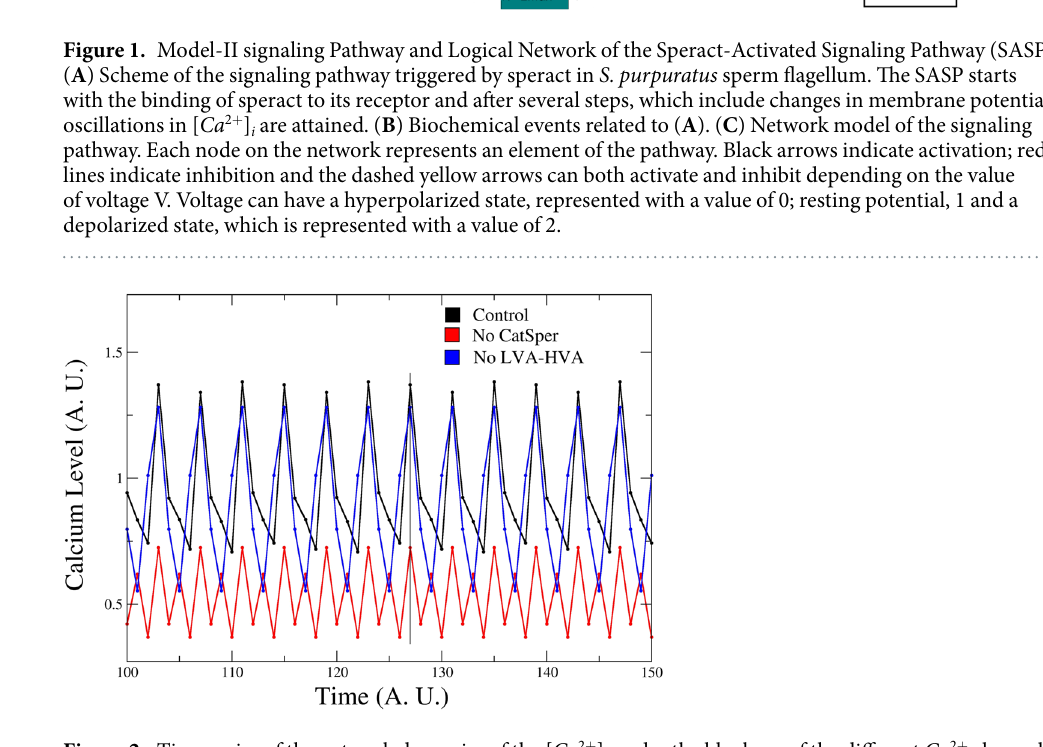
Figure 2. Time series of the network dynamics of the [ Ca 2 + ] i under the blockage of the different Ca 2 + channels present in the sea urchin sperm flagellum: HVA-LVA and CatSper. The [ Ca 2 + ] i curve with all nodes present (WT) is depicted in black. Red line corresponds to the [ Ca 2 + ] i dynamics after blockage of the CatSper channel. The blue line represents the [ Ca 2 + ] i nodes of the network dynamics without both HVA and LVA channels. The X axis units are number of iterations of the network dynamics. The Y axis units are arbitrary, indicative of relative [ Ca 2 + ] i node